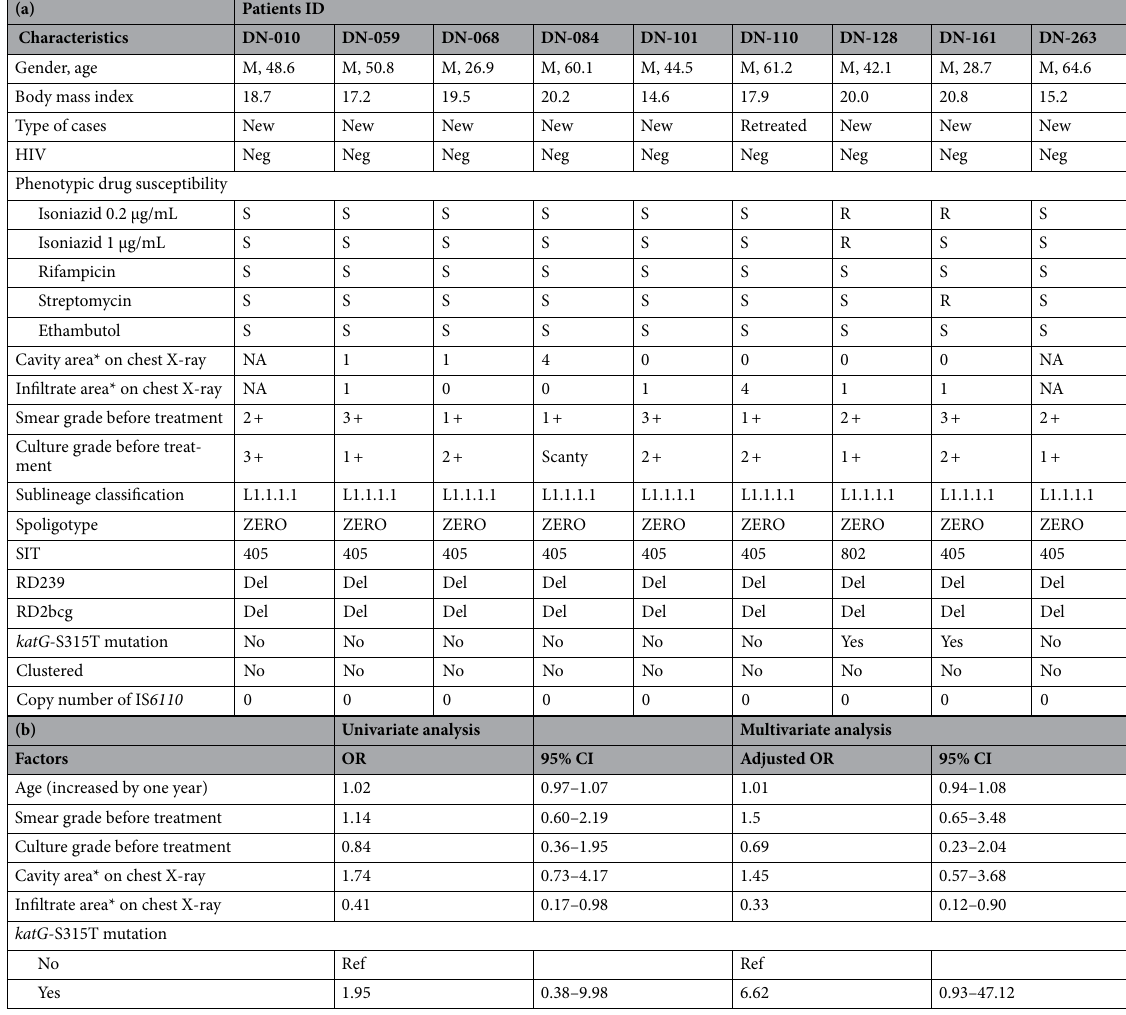
Table 3. Characteristics of ZERO strains (a) and multivariate analysis using logistic regression models to investigate factors possibly associated with ZERO strains (b). HIV human immunodeficiency virus, M male, S sensitive, R resistant, OR odds ratio, 95% CI: 95% confidence interval. *Number of lung